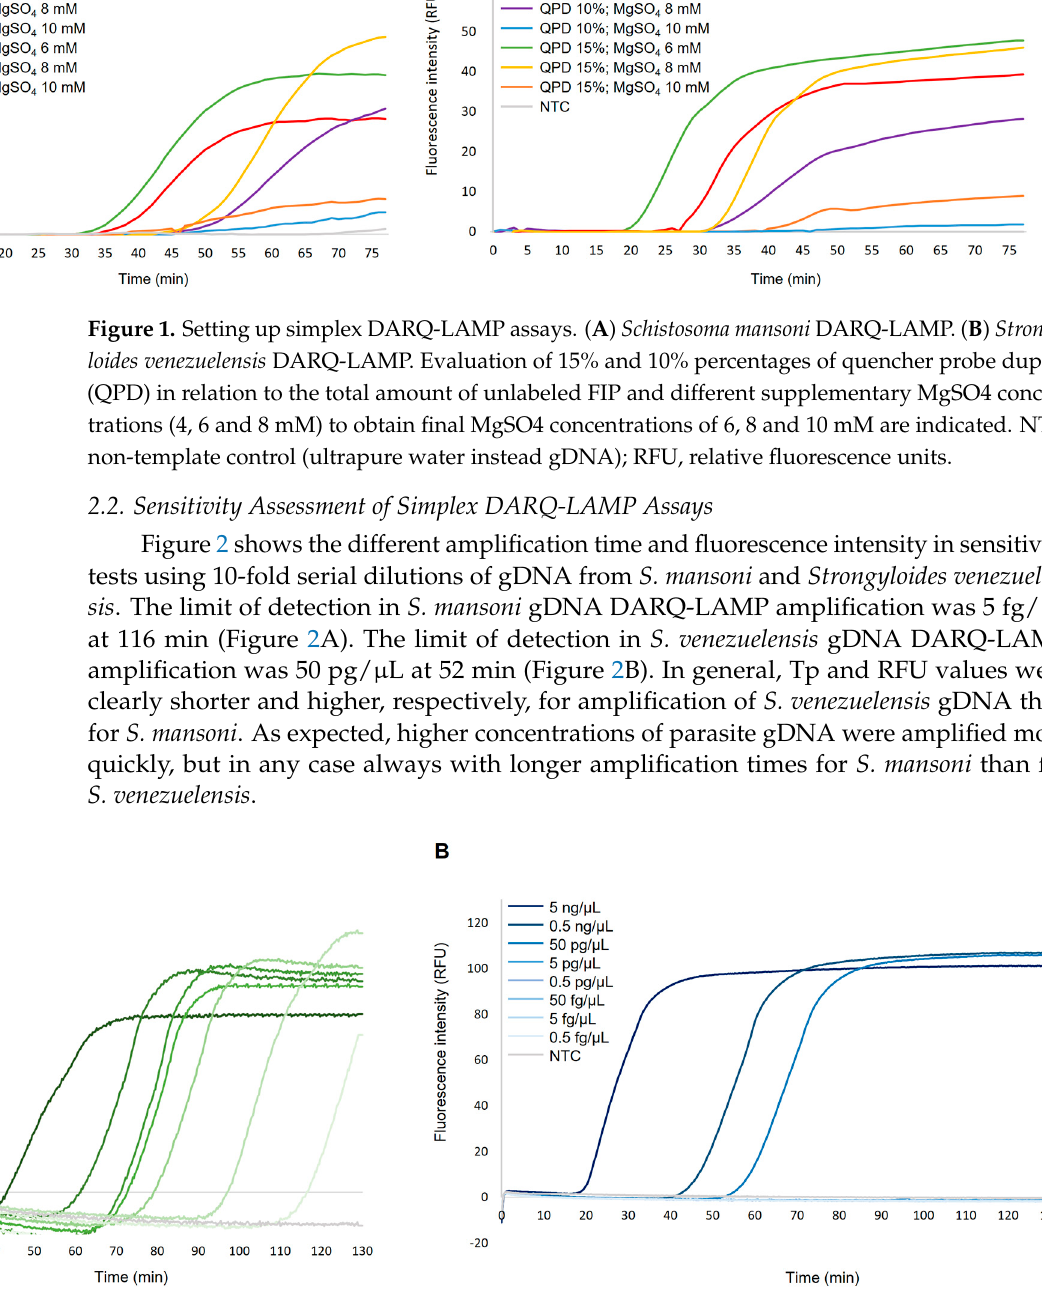
Figure 2. Sensitivity assessment of simplex DARQ-LAMP assays using the Genie III handheld device. ( A ) Analytical sensitivity for Schistosoma mansoni DARQ-LAMP reaction. ( B ) Analytical sensitivity for Strongyloides venezuelensis DARQ-LAMP reaction. The 10-fold serial dilutions (5 ng/µL to 5 fg/µL) of gDNA from parasites are represented by different shades of green (for Sm ) and blue (for Sv ). NTC, non-template control (ultrapure water instead gDNA) is represented by grey lines in both cases. RFU, relative fluorescence units.